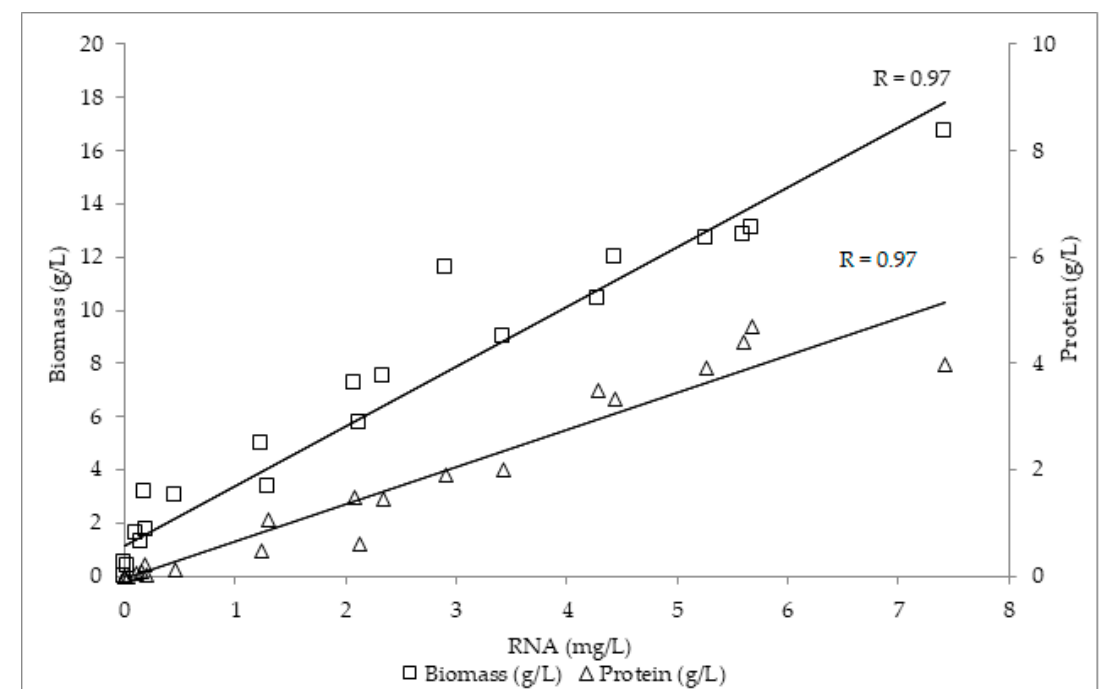
Figure 4. Correlation among RNA vs. biomass and RNA vs. protein of A. bisporus , A. subrufescens , P. eryngii and P. ostreatus.